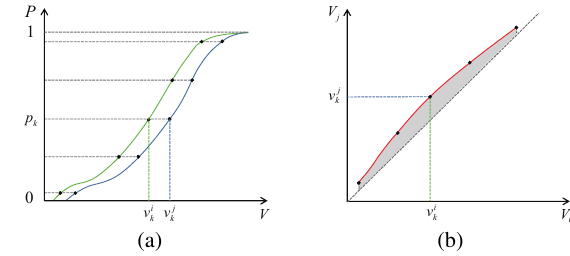
Figure 4. An illustration of measuring the distance of histograms: (a) the two CDF curves of the overlapping regions from an image pair ( I i ; I j ) with discrete nodes at equal interval probabilities; (b) the fitted curve by the quadratic B-spline fitting for histogram mapping, forming a shadow region with the clino-diagonal line ( base line ).